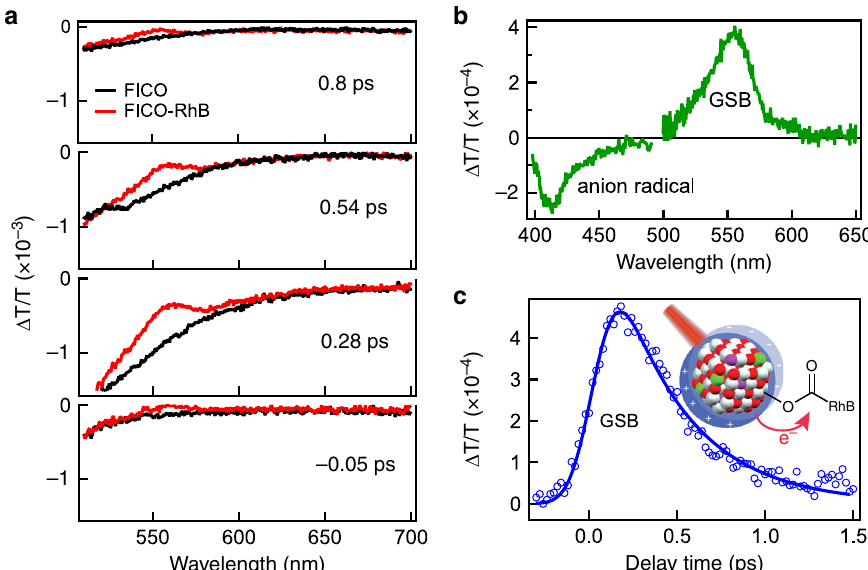
Fig. 3 Hot-electron transfer from FICO. a Comparison of transient absorption (TA) spectra at different delay times for FICO nanocrystals (NCs) and FICO – RhB. b Subtracted TA spectrum showing clearly RhB ground state bleach (GSB) and anion radical induced absorption (IA). c TA kinetics of RhB GSB kinetics (empty circles) and the exponential fi tting (blue line) in FICO – RhB complex. Inset: scheme of PIHET from FICO NCs (red: O; white: Cd; green: In; violet: F) to RhB molecules. After infrared light excitation (red beam), the hot-electron transfers to the adsorbed RhB (red arrow).